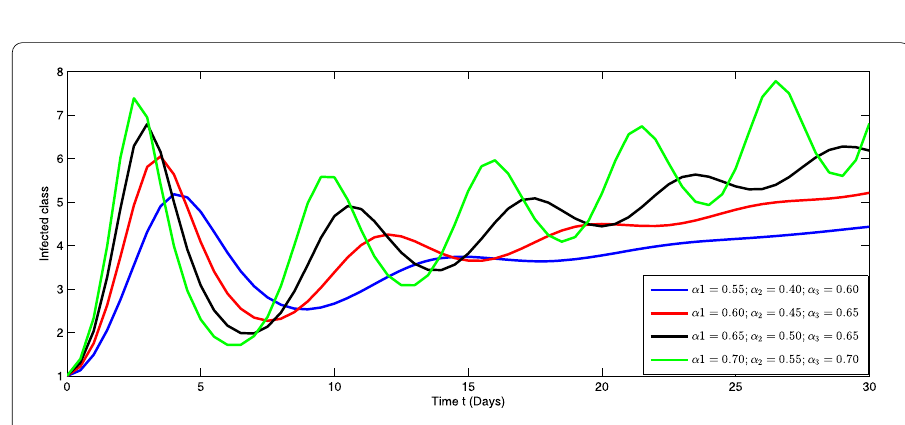
Figure 7 Dynamical behavior of I for different values of α i ( i = 1,2,3) at integer order